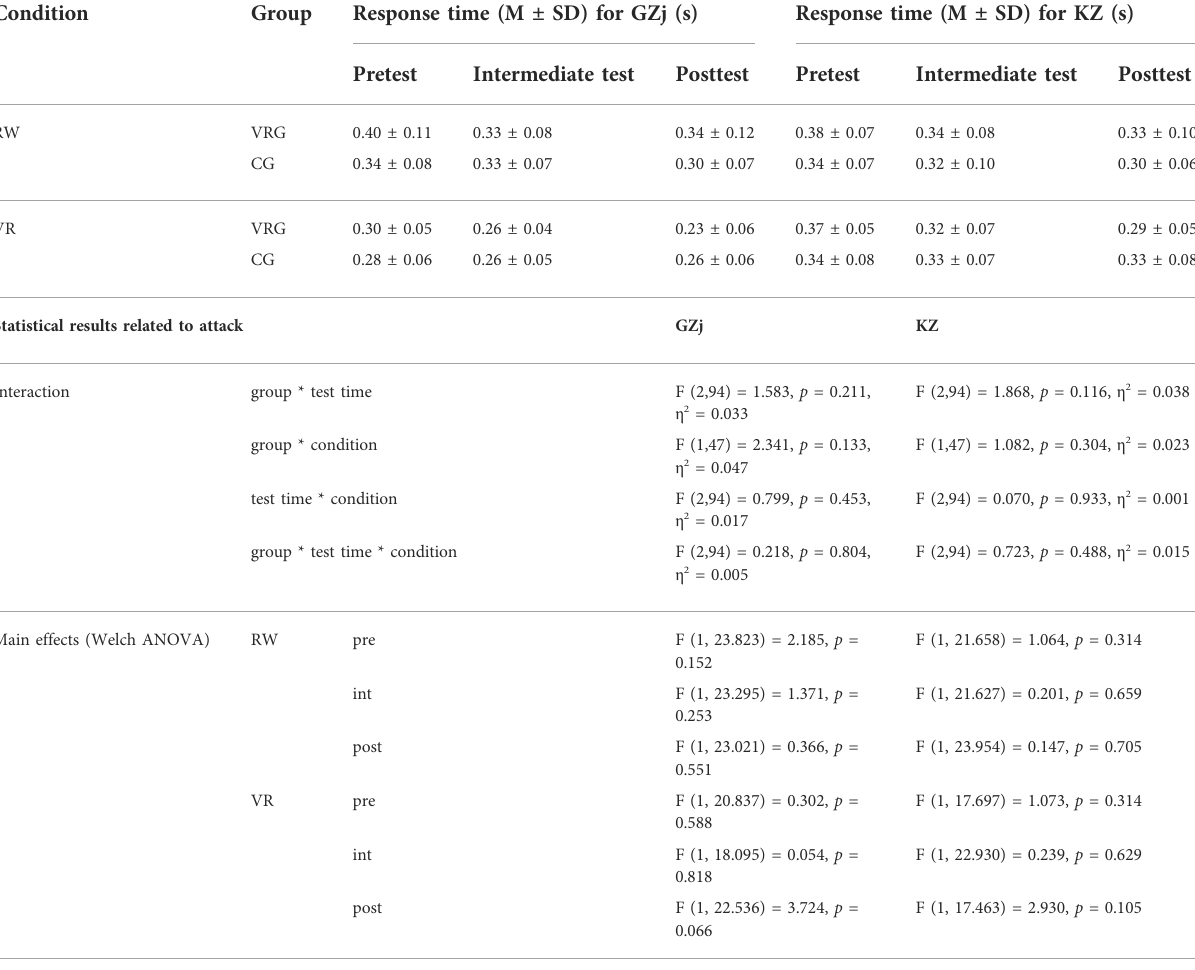
TABLE 1 Results for “ response time ” (s) for each attack (GZj, KZ), for each test time (pretest, intermediate test, posttest), for each condition (RW, VR), and each group (VRG, CG). For the parameter “ response time, ” a smaller value represents a shorter time until the athlete started his response towards the attack of the opponent.